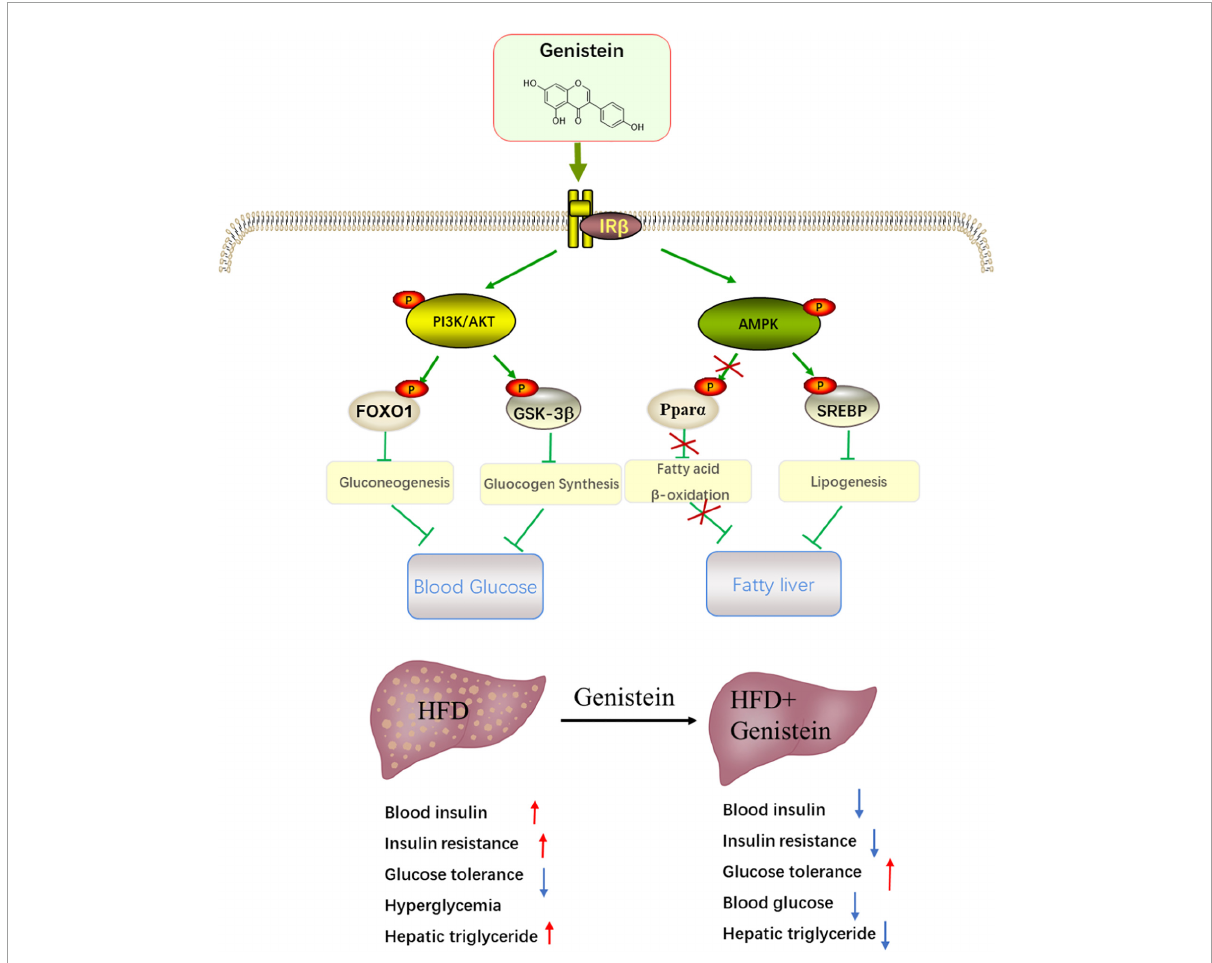
FIGURE8 Schematic showing the potential mechanism through which genistein ameliorates hyperglycemia and fatty liver induced by HFD. Schematic diagram summarizes that genistein maintains glucose homeostasis to protect from HFD-induced insulin resistance and fatty liver by modulating insulin signaling pathway and energy status in the